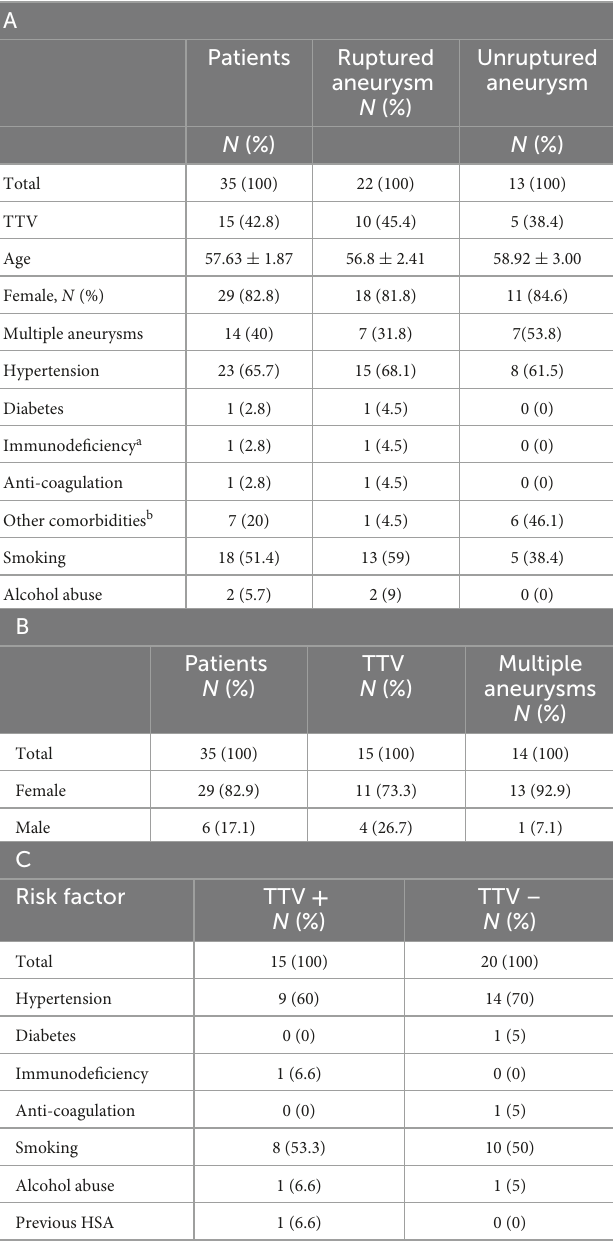
TABLE 1 (A) Demographic characteristics of 35 patients with aneurysm; (B) patient characteristics categorized by gender and virus positivity on the among patients TTV positive and TTV negative.